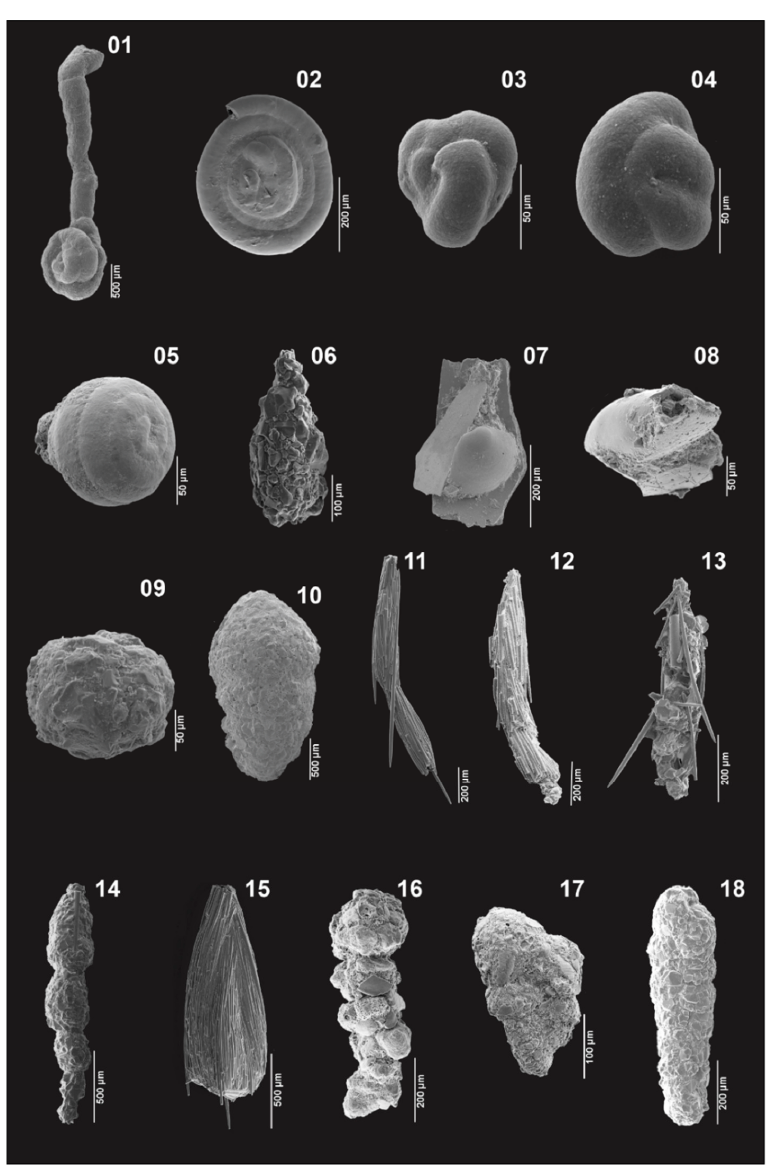
Figure A1. Plate I: 1— Lituotuba lituiformis (Brady, 1879), side view; 2— Glomospira gordialis (Jones &